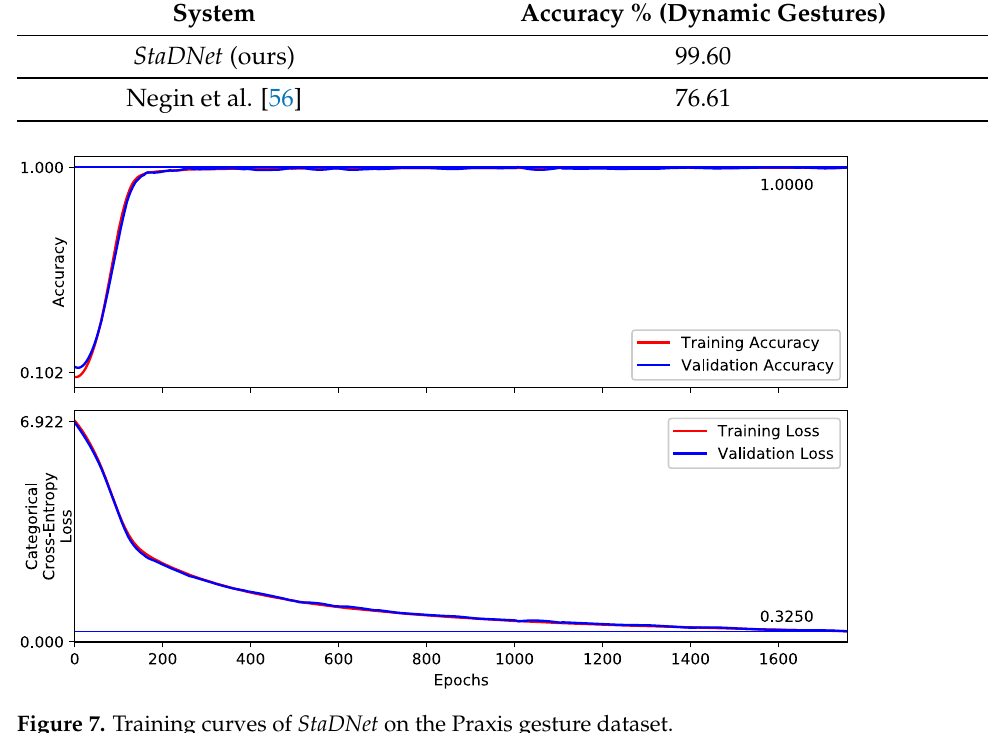
Figure 7. Training curves of StaDNet on the Praxis gesture dataset.